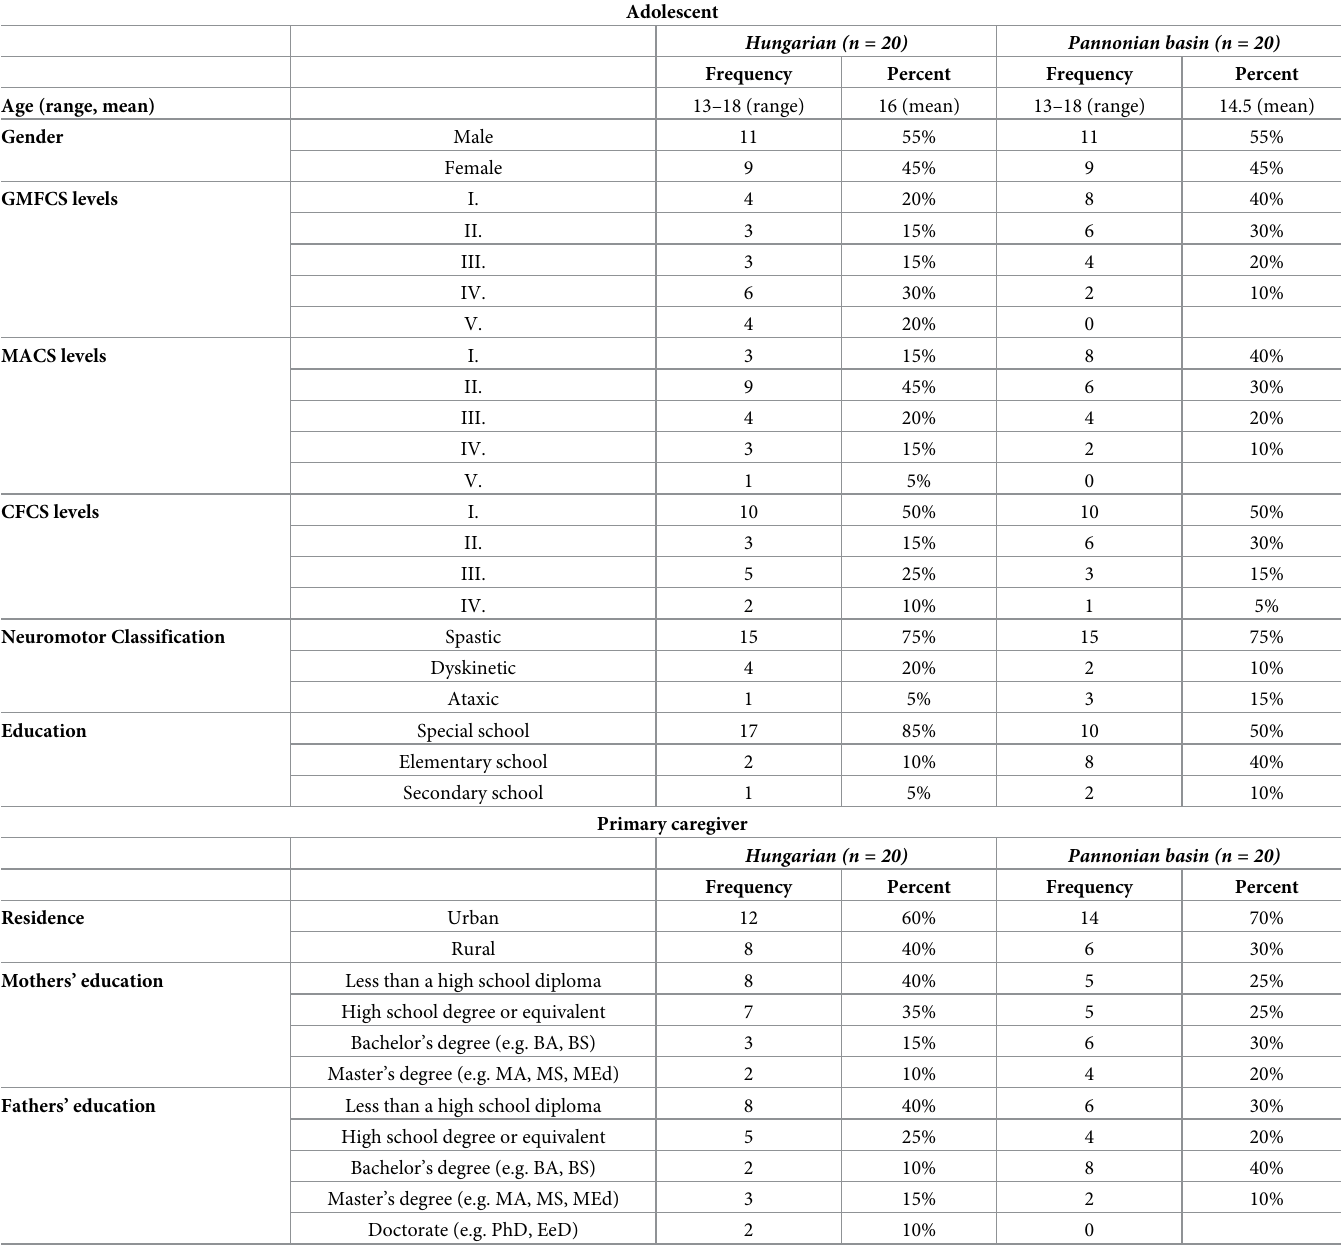
Table 1. Demographic